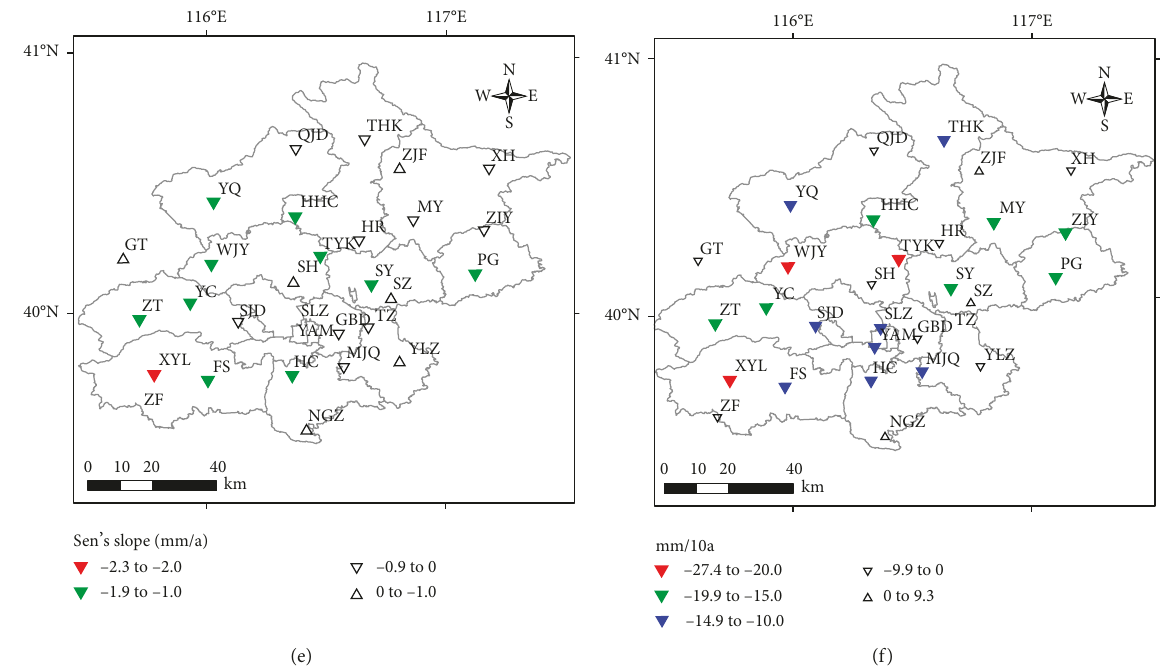
Figure 6: The spatial distribution of mean precipitation and their statistical characteristics and trends in Beijing during 1960–2012: (a) the annual mean precipitation, (b) the coefficient of variation, (c) the standard deviation, (d) the M-K test, (e) Sen’s slope, and (f) the linear